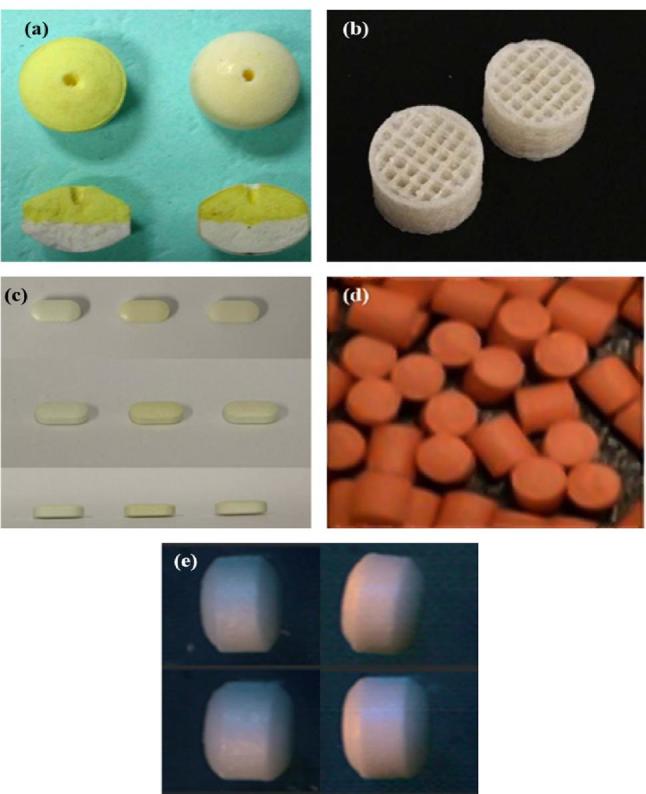
Ethocel™ polymer based: (a) osmotic tablet (adapted from Liu and Xu, 2008), (b) 3-D printed tablet (adapted from Yang et al., 2018), (c) gastroretentive tablet (adapted from Czarnocka and Alhnan, 2015), (d) mini-matrix tablets (adapted from Garber et al., 2015), (e) mini-tablet (adapted from Mohamed et al., 2015) dosage forms.